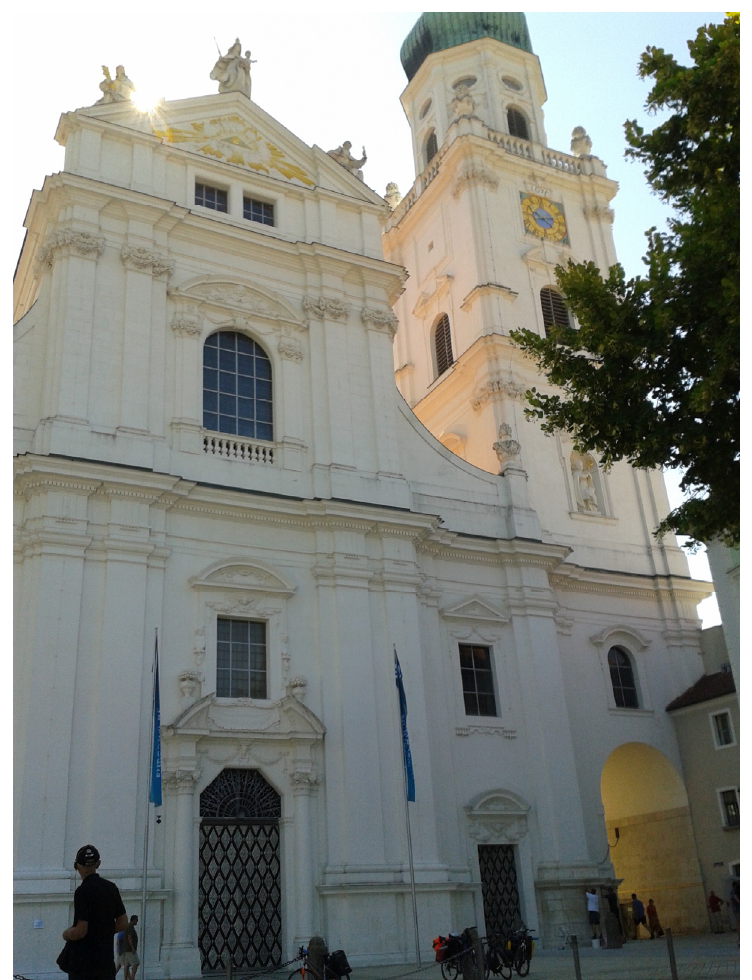
Figure 6. Unification of the color of the natural light stone face covered entirely with a lime coating: the façade of Pasava Cathedral (1668–1693). Photo by author.